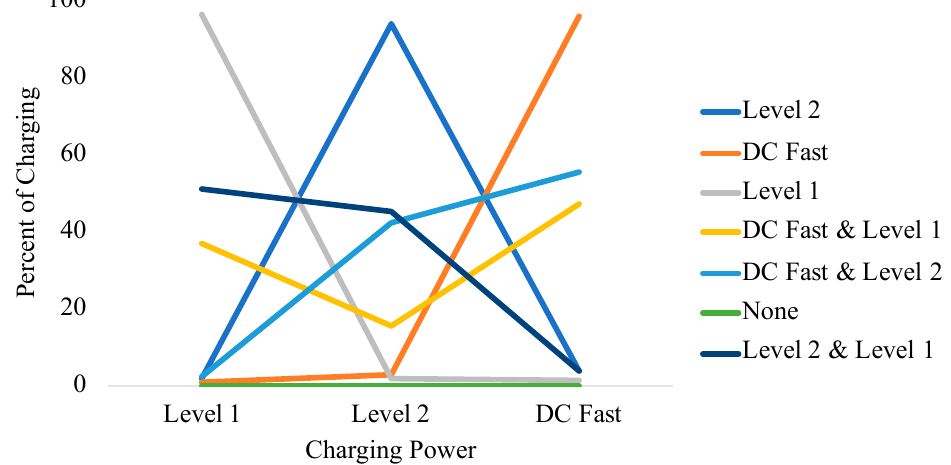
9 of 13 Figure 10. Mean distribution of charging location.